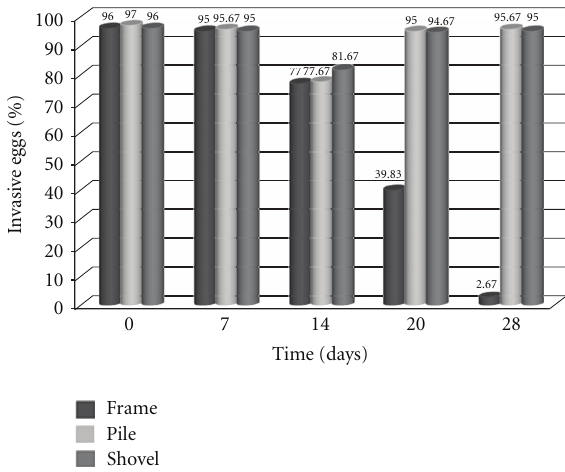
Figure 11: The course of inactivation of Ascaris suum eggs in summer cycle